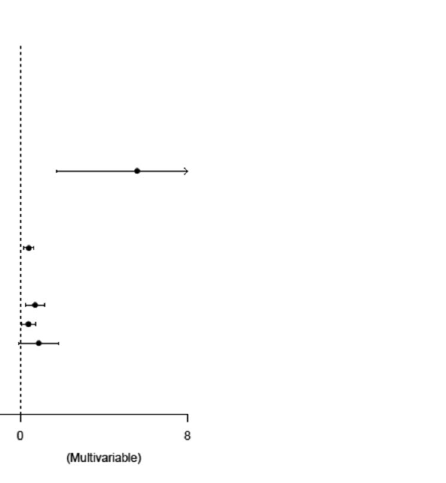
Figure 1. Forest plots showing the logistic regression analyses of clinical characteristics for a prior history of falls in patients with early Parkinson’s disease.